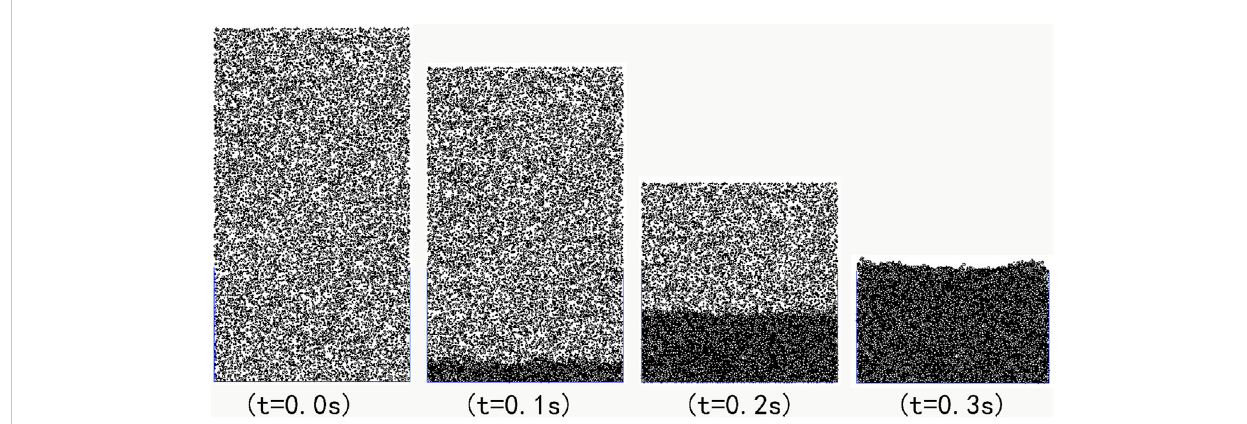
FIGURE 7 Soil particles down freely in the soil bin at t = 0.0, 0.1, 0.2, 0.3 s, respectively.